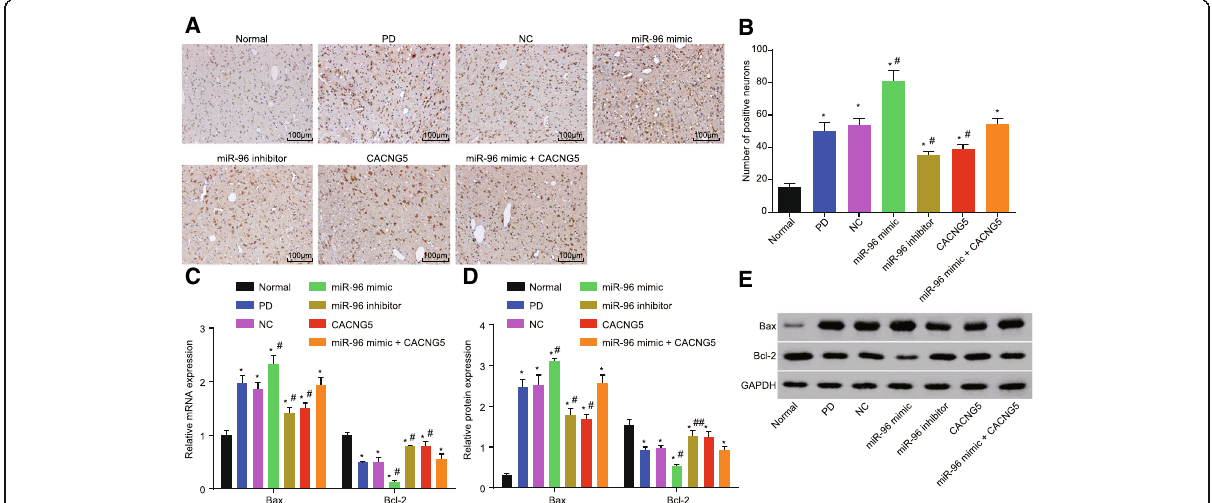
Fig. 6 Lower Bax and higher Bcl-2 were found after transfection of miR-96 inhibitor. a TUNEL staining of dopaminergic neuronal tissues among seven groups (× 100); b positive cells among seven groups under a microscope; c mRNA expression of Bax and Bcl-2 among seven groups evaluated by RT-qPCR; d protein expression of Bax and Bcl-2 among seven groups evaluated by Western blot; e protein bands of Bax and Bcl-2 among seven groups; Bar = 50 μ m. The test was repeated three times independently, and the one-way ANOVA analysis was used for comparison among multiple groups ( n = 10 in each group). * , P < 0.05 compared with the normal group, # , P < 0.05 compared with the PD and NC groups; TUNEL, terminal deoxynucleotidyl transferase-mediated dUTP nick-end-labeling; RT-qPCR, reverse transcription quantitative polymerase chain reaction; Bcl-2, B-cell lymphoma-2; Bax, Bcl-2 associated protein X; miR-96, microRNA-96; CACNG5, calcium voltage-gated channel auxiliary subunit gamma 5; PD, Parkinson ’ disease; NC, negative